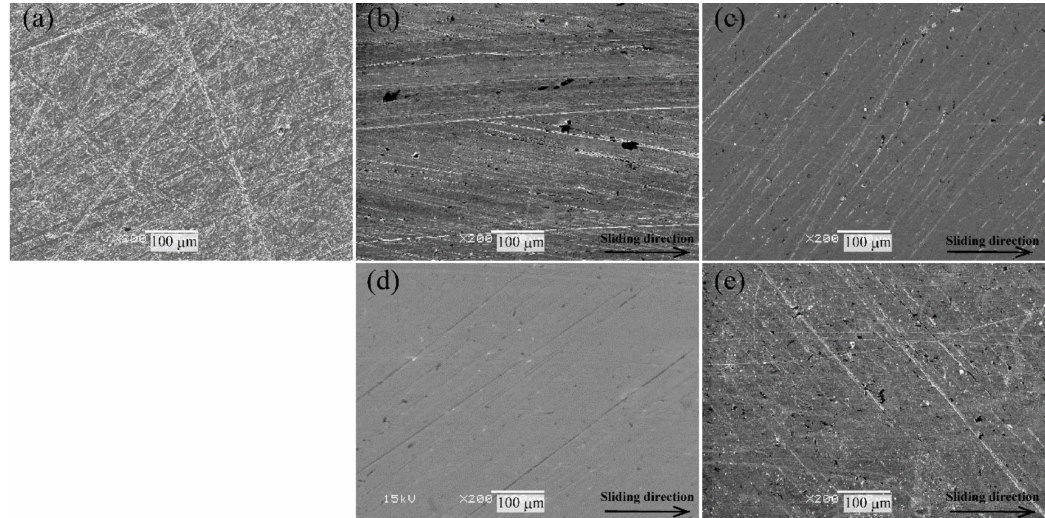
Figure 9. SEM photographs of metallic counterface (carbon steel S45C) before and after sliding wear tests of various surface- treated HF/PA1010 biomass composites: ( a ) surface before sliding, ( b ) surface after sliding for HF_NaClO 2 , ( c ) surface after sliding for HF_NaClO 2 + EP, ( d ) surface after sliding for HF_NaClO 2 + A-1160, and ( e ) surface after sliding for HF_NaClO 2 + A-1160 + EP) ( ×